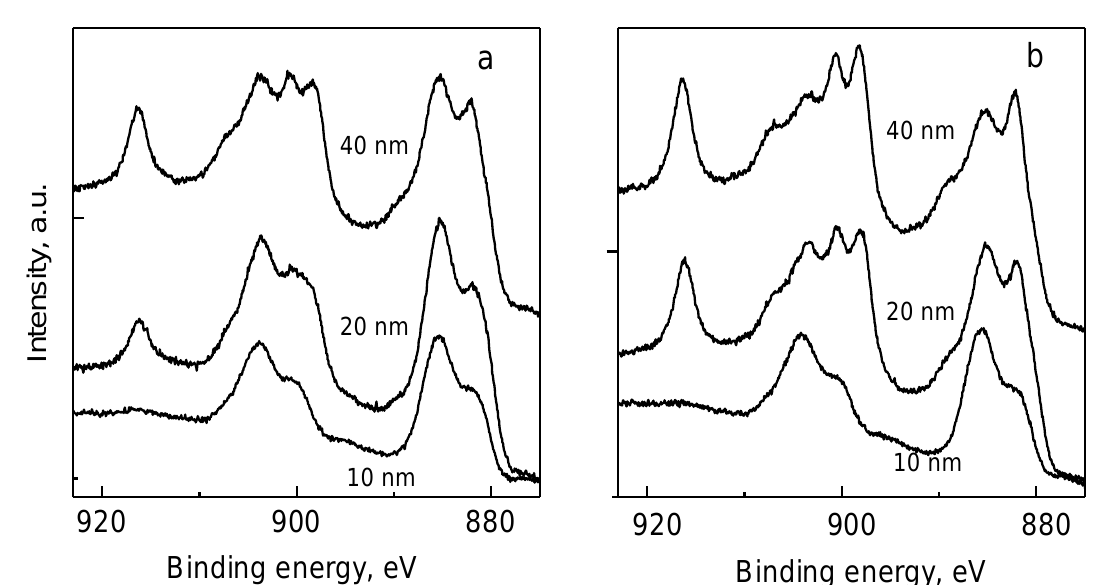
Figure 5. X-ray photoelectron spectroscopy (XPS) spectra of Ce 3d for Fe/P-Mo-Ce1 ( a ) and Fe/P-Mo-Ce2 ( b ) samples after Ar sputtering for different times.